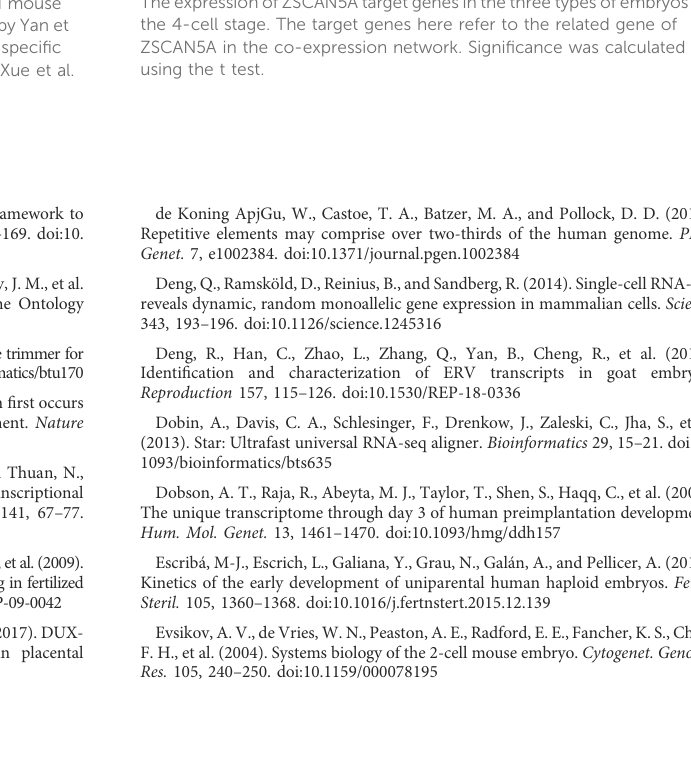
(above), and the number of each transposon family in stage-speci fi c transposons(below). (C) Fuzzy clustering analysis of TEs expression signals for the fi ve consecutive stages in mouse. The closer the line color is to red, it means that these are the core TE in the cluster (left). Number of core TE of each class in each cluster. Select transposons with membership value greater than 0.7 as core TE in each cluster and count the number of four (membership > =0.7) (right) SUPPLEMENTARY FIGURE S2 RelatedtoFigure2. (A) Thenumberofupregulatedgenesateachstageof three types of embryos. (B) The number of transposons up-regulated from 2- to 4-cell stage in BI embryos overlapped with the transposons down-regulated in uniparental embryos than in BI embryos at the 4-cell stage. SUPPLEMENTARY FIGURE S3 The four modules most relevant to the 2-cell to the morula stage. (A) Scatterplot of gene signi fi cance (GS) for stages versus module membership (MM) in the four modules. GS and MM exhibit a very signi fi cant correlation, implying that hub genes of the four modules also tend to be highly correlated with the corresponding stage. (B) The expressions of eigengene in the four modules in all samples. The eigengenes of the four modules are all highly expressed in the corresponding stages. SUPPLEMENTARY FIGURE S4 The network diagrams of the four modules relevant to the 2-cell to the morula stage. The dot plot shows the comparison of the expression of the top ten TFs among the four modules in the three types of embryos(a, b, c, andd for 2-, 4-, 8-, and morula, respectively). The color of the dot represents the type of embryo, and the shape represents the stage. SUPPLEMENTARY FIGURE S5 GO function enrichment analysis of genes in the four modules. Genes in pink module are related to histone modi fi cation and methylation, genes in purple modules are related to regulation of gliogenesis differentiation, genes in yellow modules are related to RNA splicing and chromatin assembly, genes in turquoise modules are related to protein transport in the endoplasmic reticulum. SUPPLEMENTARY FIGURE S6 TheexpressionofZSCAN5Atarget genesinthethreetypesofembryosat the 4-cell stage. The target genes here refer to the related gene of ZSCAN5A in the co-expression network. Signi fi cance was calculated using the t